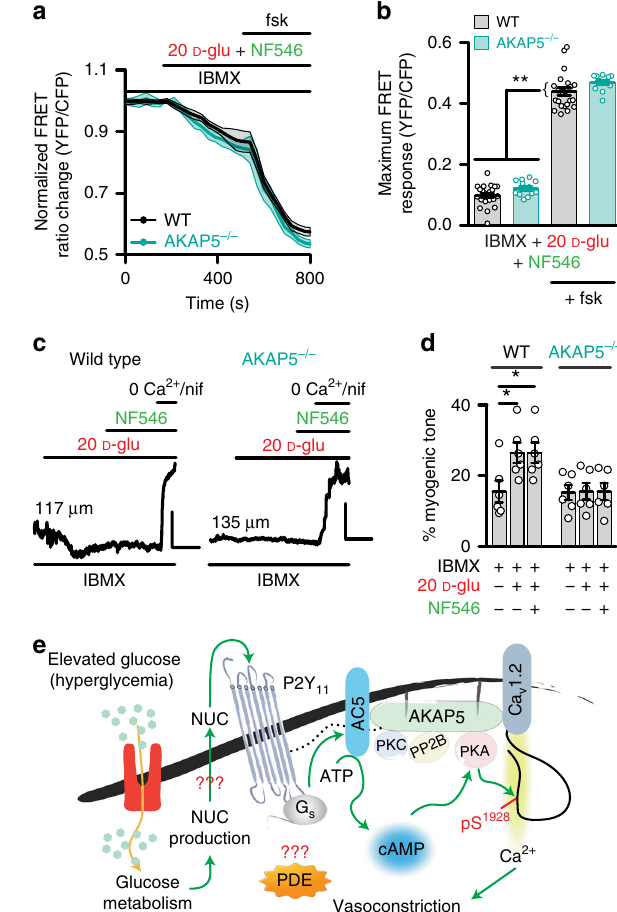
Fig. 7 PDE inhibition restores cAMP signal but not vasoconstriction in AKAP5 − / − tissue. a Time courses of the average ICUE3-PM traces (mean = solid line; SEM = shade) and b summary data of wild-type (WT; n = 22 cells/3 mice) and AKAP5 − / − ( n = 12 cells/3 mice) arterial myocytes pretreated with the broad phosphodiesterase (PDE) inhibitor 3-isobutyl-1-methylxanthine (IBMX; 100 μ M) in response to 20 mM D- glucose (D-glu) + NF546 and after application of forskolin. * P < 0.05 with two-tailed Mann – Whitney test. The single asterisks highlight signi fi cant differences between datasets in the absence of forskolin. The double asterisks indicate a statistical difference within the same experimental group in the absence and presence forskolin. All signi fi cant P values are <0.0001. c Exemplary diameter recordings and d summary myogenic tone data from WT ( n = 6 arteries/4 mice) and AKAP5 − / − ( n = 6 arteries/3 mice) cerebral arteries pretreated with IBMX (100 μ M) before and after application of 20 mM D-glu and subsequent NF546. Scales = 10 μ m (vertical) and 5 min (horizontal). Initial diameters shown on the traces left side. * P < 0.05 with Friedman one-way ANOVA with Dunn ’ s multiple comparisons. Statistical differences were compared between datasets within the same phenotype. P = 0.0281 for WT 10 mM D-glu + IBMX- 20 mM D-glu + IBMX, and P = 0.0281 for WT 10 mM D-glu + IBMX- model for an AKAP5-dependent signaling module formed by P2Y 11 /P2Y 11 - like receptor, AC5, PKA and Ca V 1.2, which regulates L-type Ca 2 + channel activity via Ca V 1.2 serine 1928 phosphorylation (pS 1928 ). Glucose-induced potentiation of L-type Ca 2 + channel activity promotes vasoconstriction. The dotted black line is to re fl ect close association between AKAP5 and P2Y 11 . PP2B = calcineurin. ATP = adenosine triphosphatase. The mechanisms of PDE regulation and nucleotide (NUC) release remain unclear as denoted by the red question mark symbols. Source data are provided as Source data fi